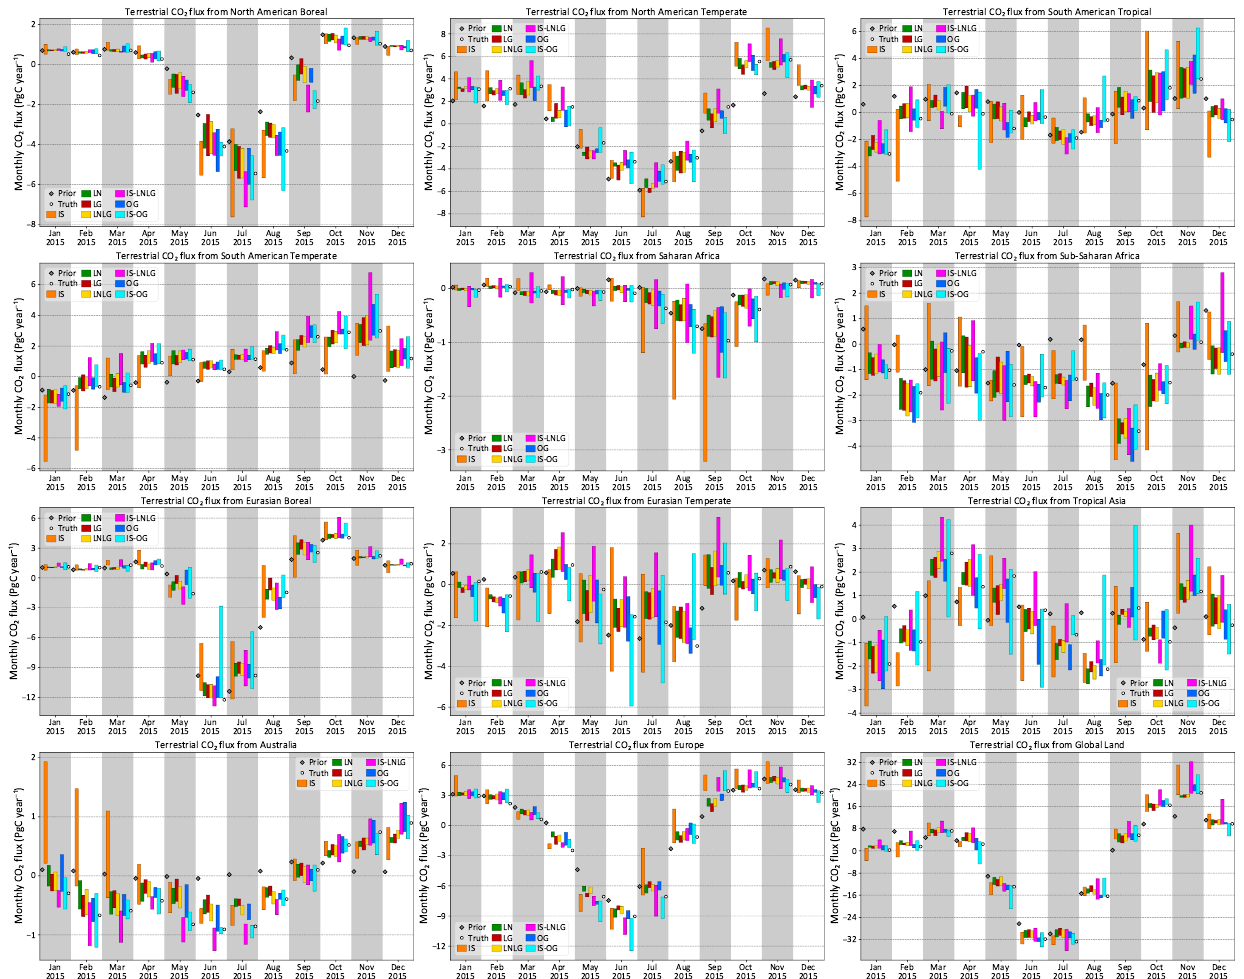
Figure 5. Monthly flux estimates from TRANSCOM-like land regions and global total land. The different colors correspond to different synthetic data streams assimilated, as in Fig. 4. The different models used to generate the synthetic data have not been distinguished here to minimize visual clutter. The theoretical PBL networks IS-LNLG and IS-OG have also been omitted for the same reason. Plots of seasonal fluxes over many more regions, with the models distinguished, are included in the